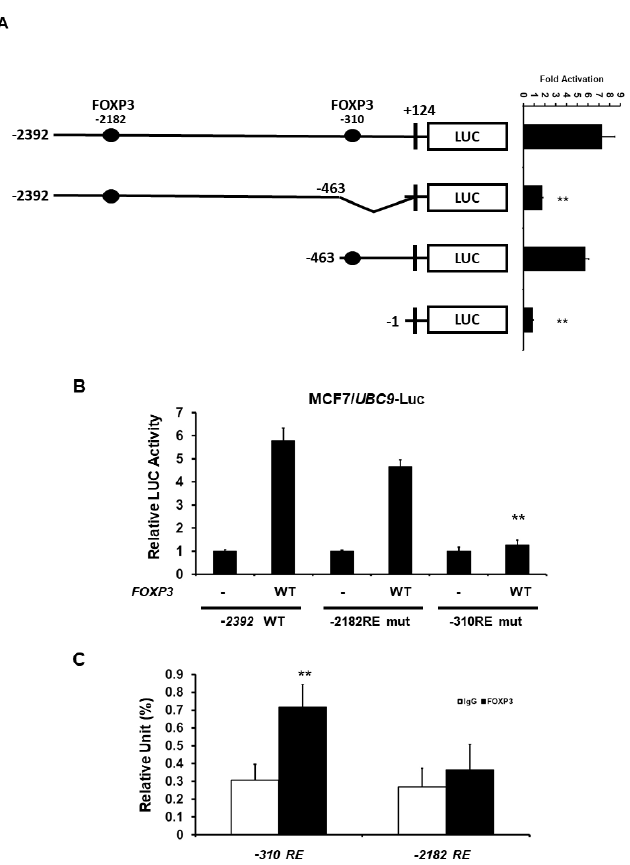
Figure 4. Regions of UBC9 promoter important for transcriptional activation by FOXP3. ( A ) MCF7 cells were co-transfected with UBC9 promoter deletion constructs and FOXP3 expression plasmid. Luciferase activities were measured 48 h after transfection and normalized with Renilla activity. Relative LUC activity (fold activation) was calculated and plotted. The experiments were conducted three times and in triplicate. Error bars indicate the standard error. ** indicates p < 0.001 vs. − 2392 bp construct; ( B ) MCF7 cells were co-transfected FOXP3 plasmid and with either − 2392 wild-type (WT), − 2182 RE